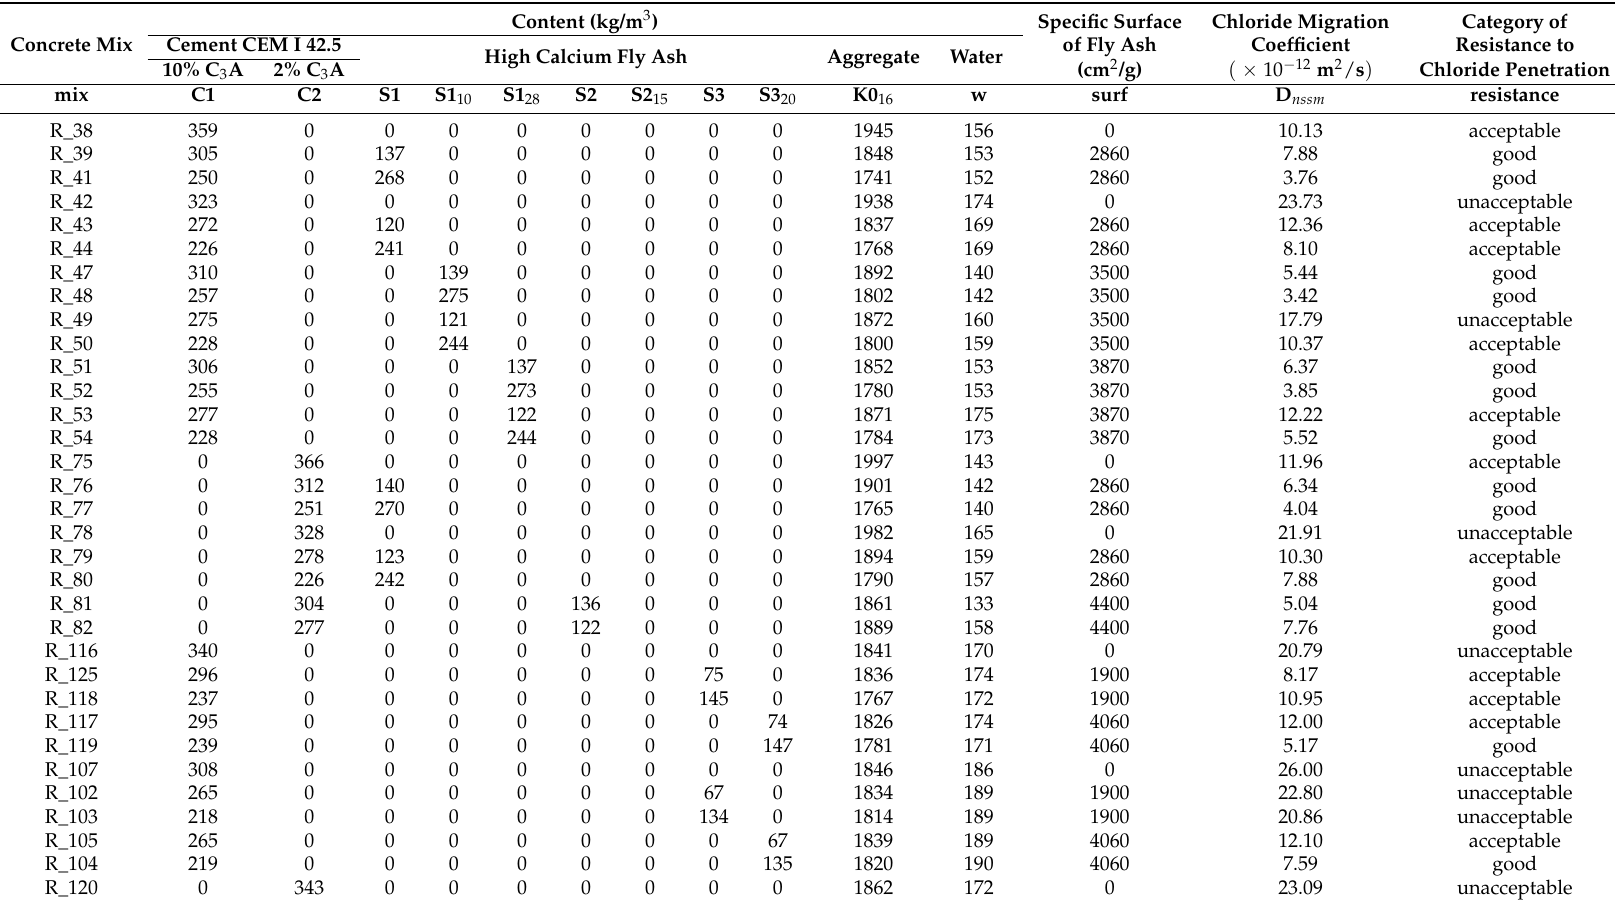
Table 4. The database of the composition of concrete mixes and the properties of hardened